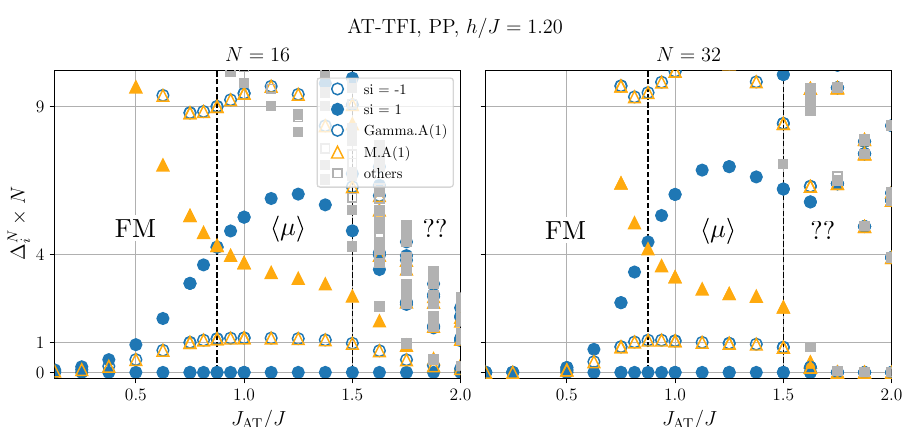
/ J for a fixed Figure 6: Low-energy spectrum for the AT-TFI model as a function of J AT h / J = 1.2 on clusters of N = 16 (left panel) and N = 32 (right panel) spins. The energy levels are characterized by their momentum Γ = ( 0,0 ) or M = ( π , π ) and their = 1, full symbols) or odd ( s = − 1, empty symbols) under quantum number even ( s i i / J ≲ 0.875 global spin inversion symmetry. The four lowest energy levels for small J AT / J ≈ 0.875 − 1.5 the four correspond to the prediction for the FM phase, while for J AT / J ≳ 1.5 the AT-TFI model lowest levels indicate the 〈 µ 〉 phase (see text). For J AT becomes strongly frustrated and the 〈 µ 〉 phase is destabilized. At the weakly first / J ≲ 0.875 the finite-size spectra approximate an O(2) rotor order transition J AT spectrum for these system sizes (see